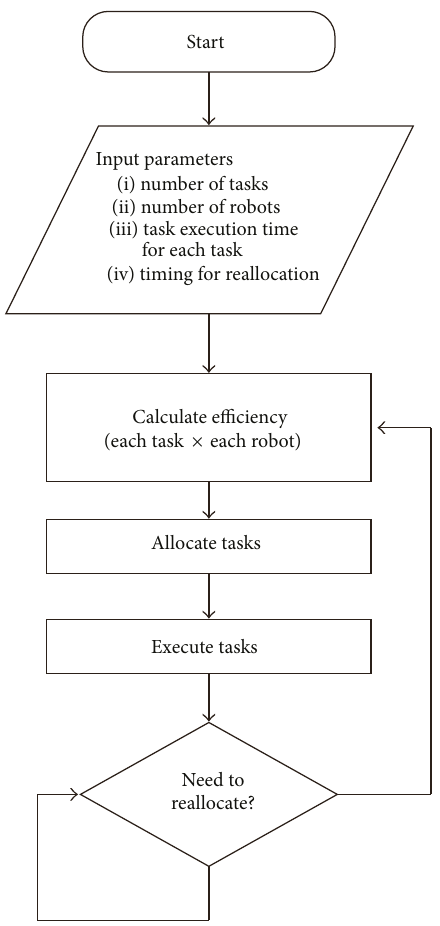
Figure 6: Allocation